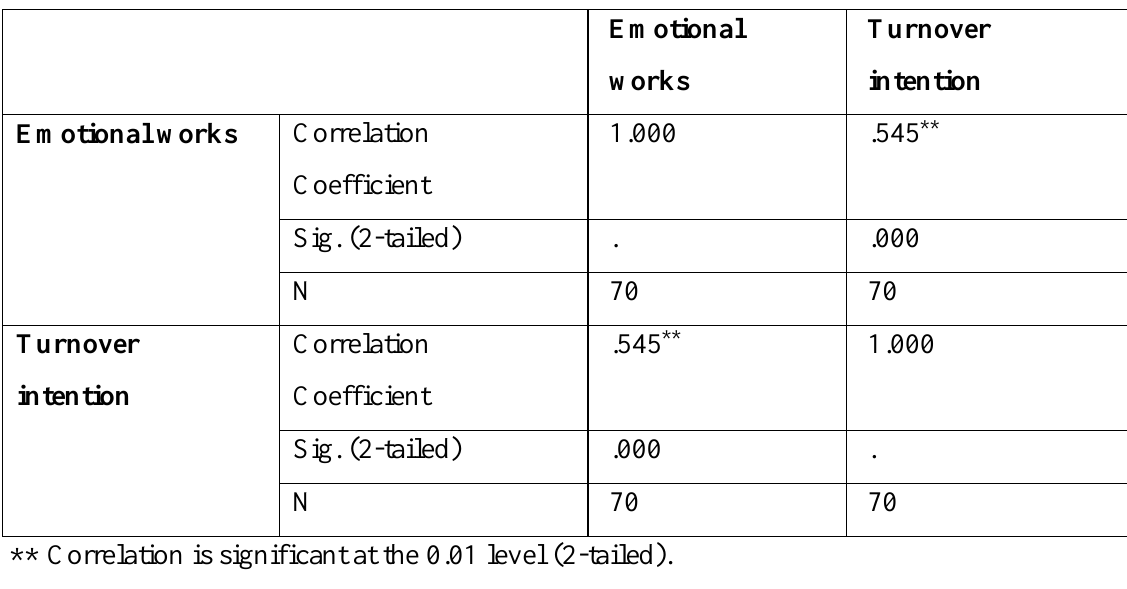
Table 3: Correlation between Emotional Works and Turnover